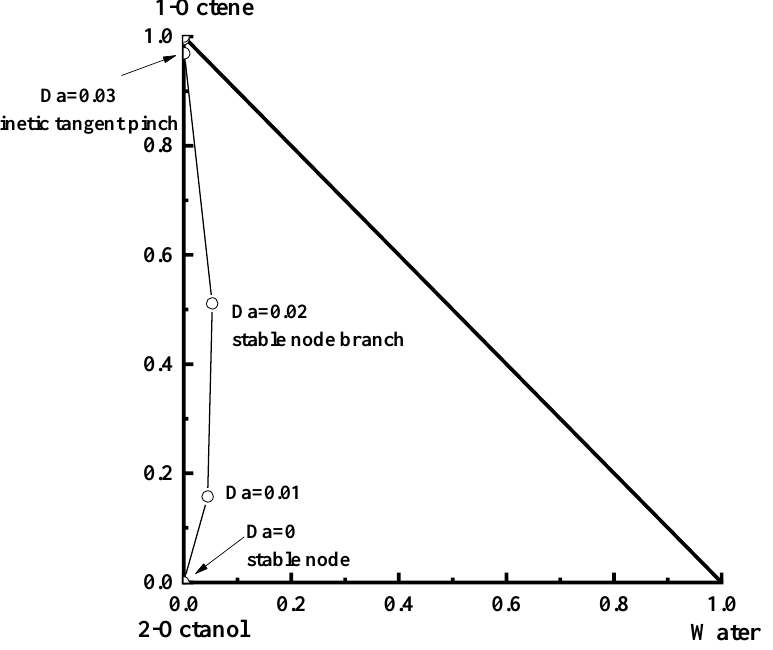
Figure 10. Trajectory plots of stable and saddle points at different Da values (1